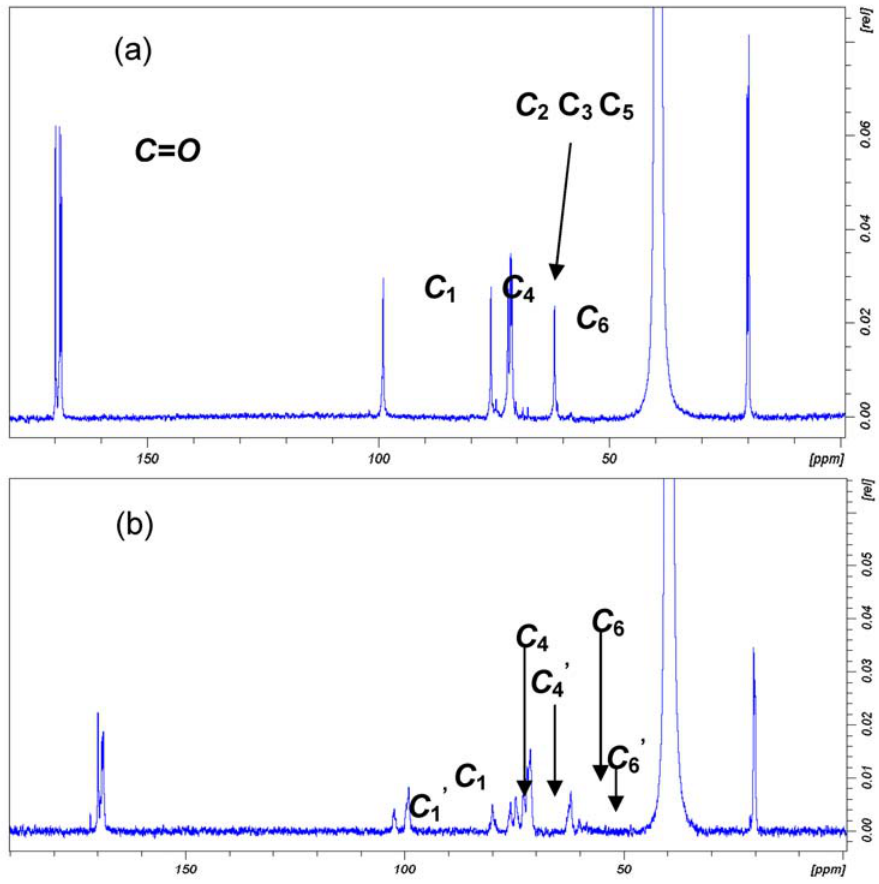
Figure 3. Comparison between the 13 C NMR spectra of cellulose triacetate F ( a ) and cellulose diacetate G ; ( b ) in DMSO-d6 in the presence of Chromium(III) acetylacetonate ( T = 323 K). Attribution of the signals is given for compound F ( a ); signal used for calculation of DS are evidenced in ( b ), where the signals of unsubstituted positions are ′ . indicated as C n